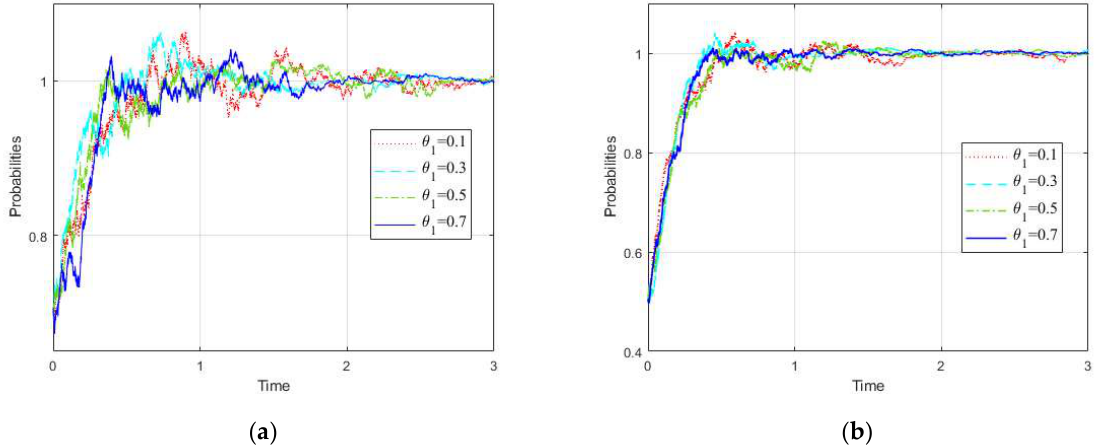
Figure 5. Influence rule of changes of θ 1 on Mainstream Government: ( a ) influence rule of changes of θ 1 on Mainstream Government when x (0) = 0.7, y (0) = 0.7, z (0) = 0.7, and ( b ) influence rule of changes of θ 1 on Mainstream Government when x (0) = 0.5, y (0) = 0.5, z (0) = 0.5. θ 1 change has little impact on the strategic choice of the mainstream